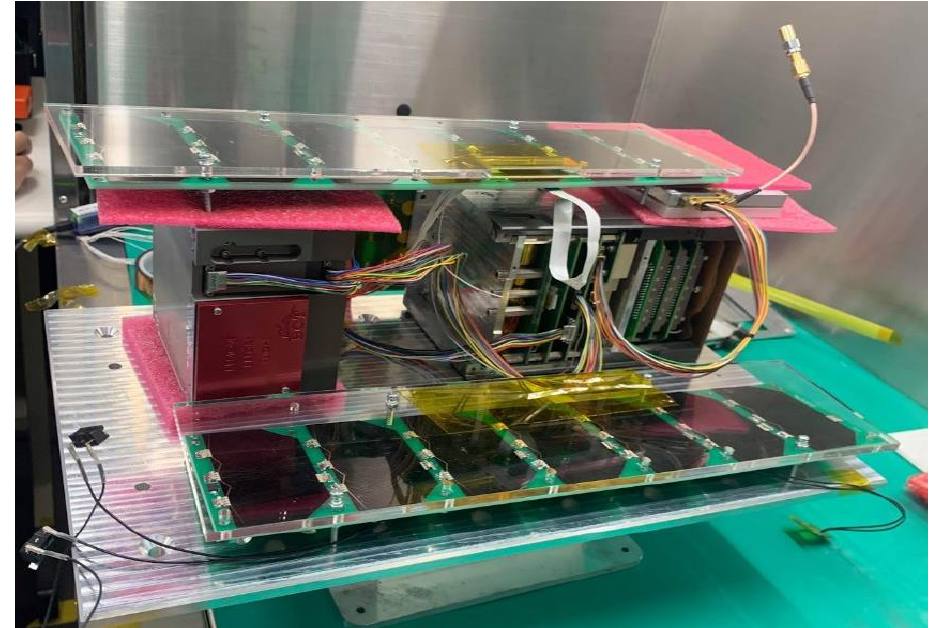
Figure 9. IDEASSat flatsat layout.